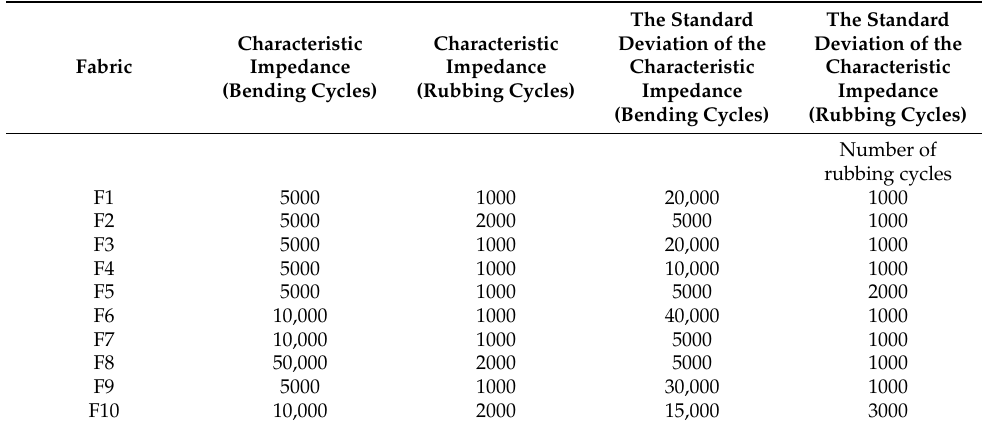
Table 5. The number of bending/rubbing cycles that caused a statistically significant change in the characteristic impedance/standard deviation of the characteristic